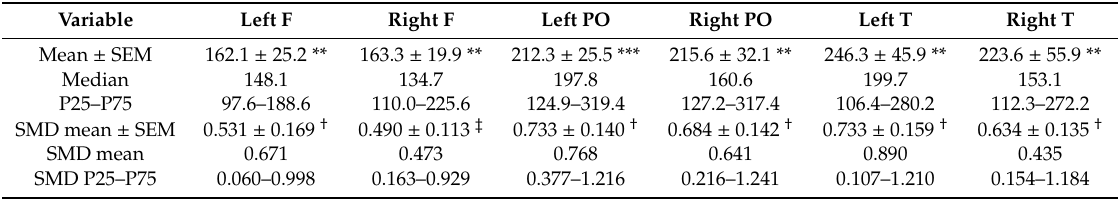
Table A6. Changes in power of delta bands during FS.